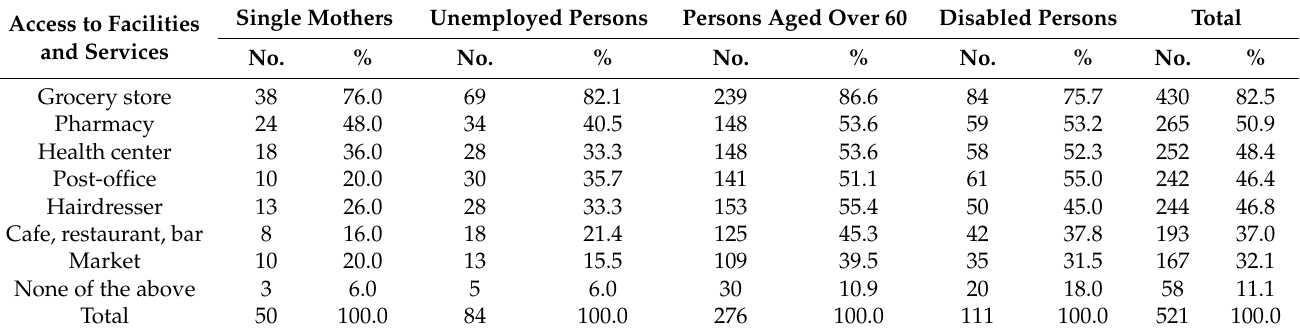
Table 9. Access to facilities and services by social status of the respondents ( n =